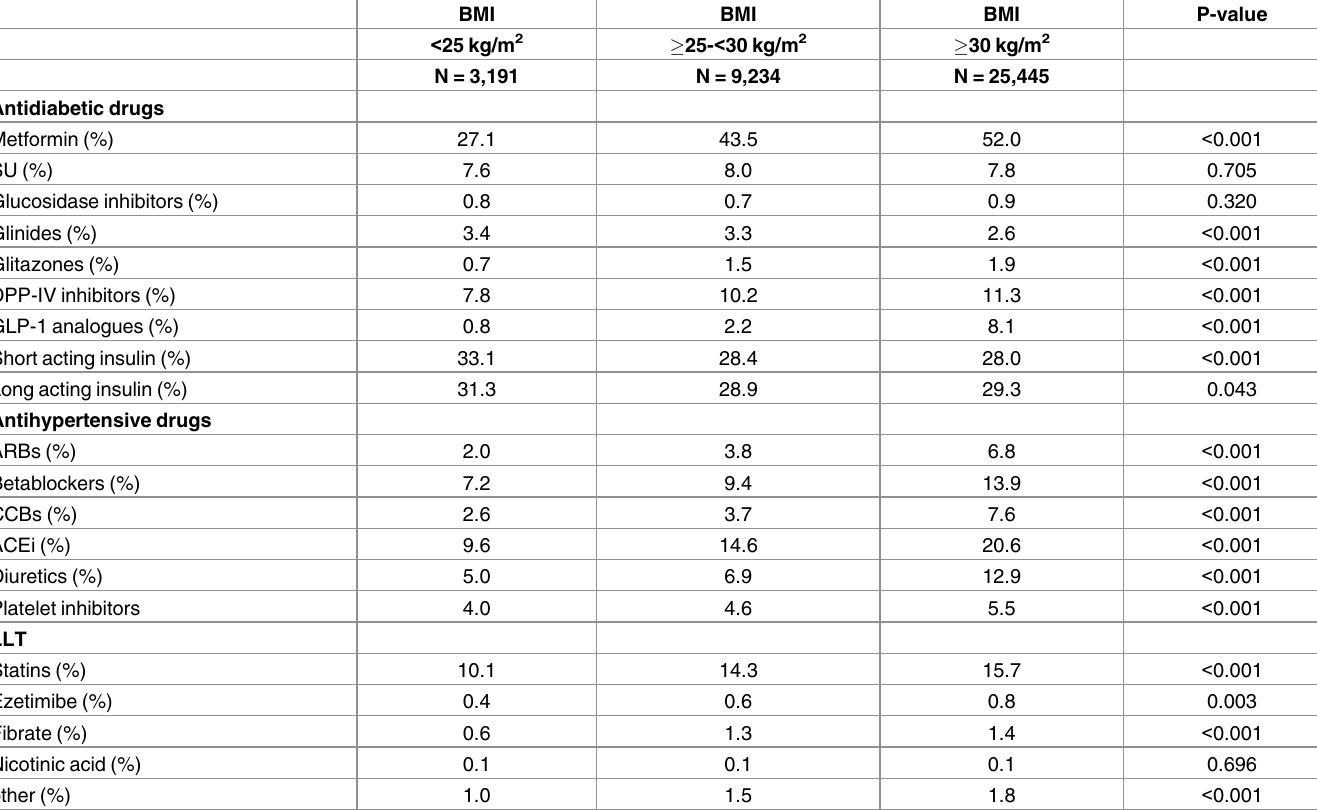
Table 3. Antidiabetic, antihypertensive and lipid lowering